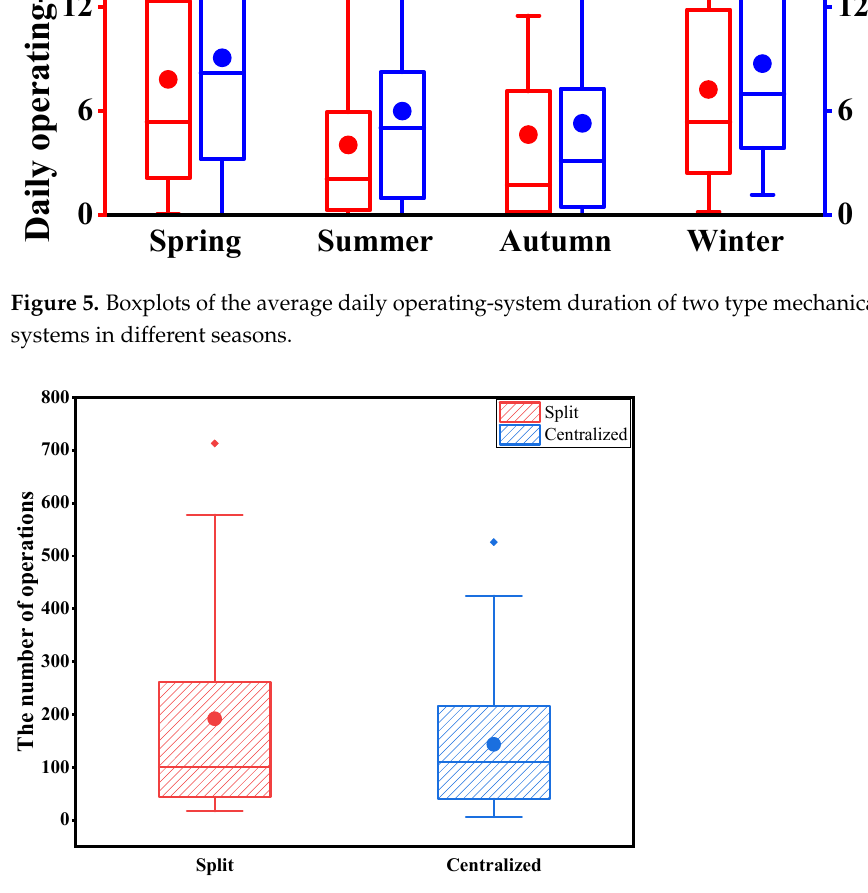
Figure 6. Boxplots of the number of times when the two types of system are operated.